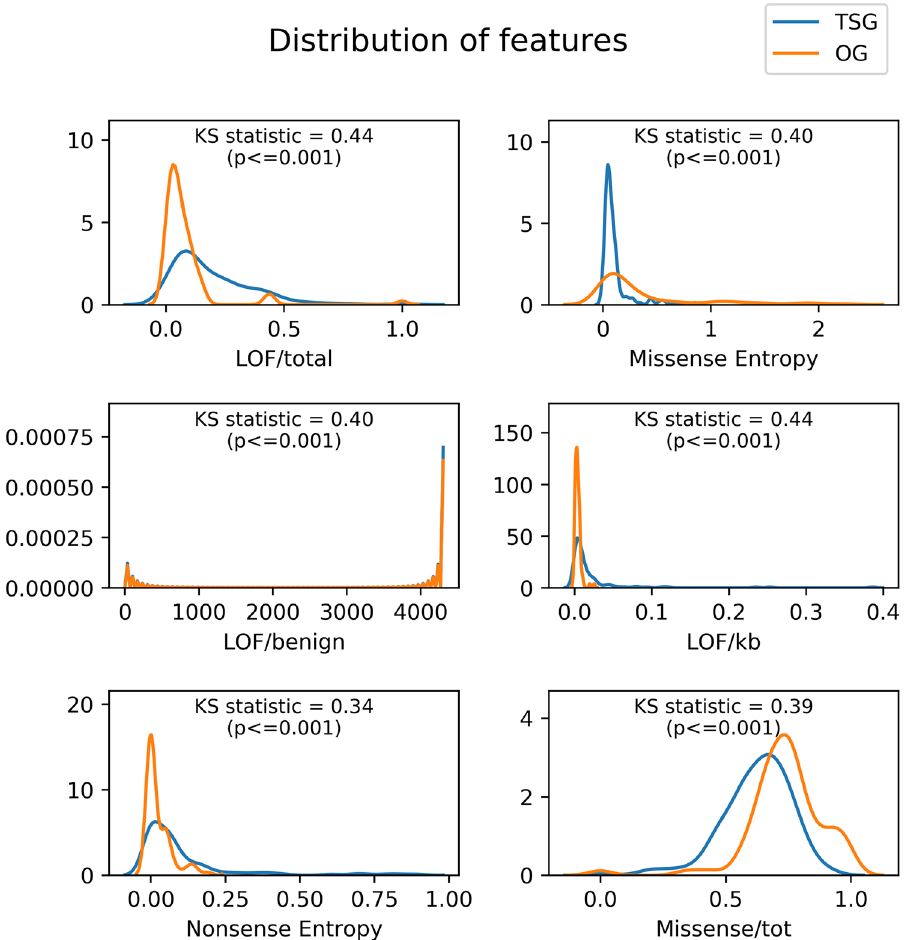
Figure 2. Distribution of top features identified by the classifier for TSG and OG. Training genes were used to study the differences between the distributions of features (kernel density) in TSG and OG. Kolmogorov– Smirnov statistic and the p-value is given for each feature. Higher value of KS statistic shows magnitude of difference of the two